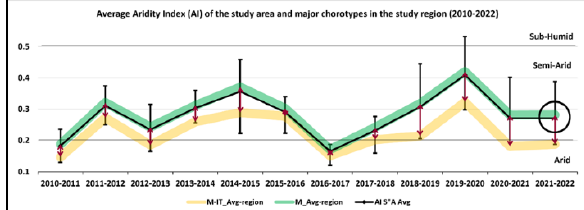
Figure 6. Range of AI in the study area (black line with high- low bars) between M-IT chorotype (yellow line) and M chorotype (green line). Current vegetation mapping circled.